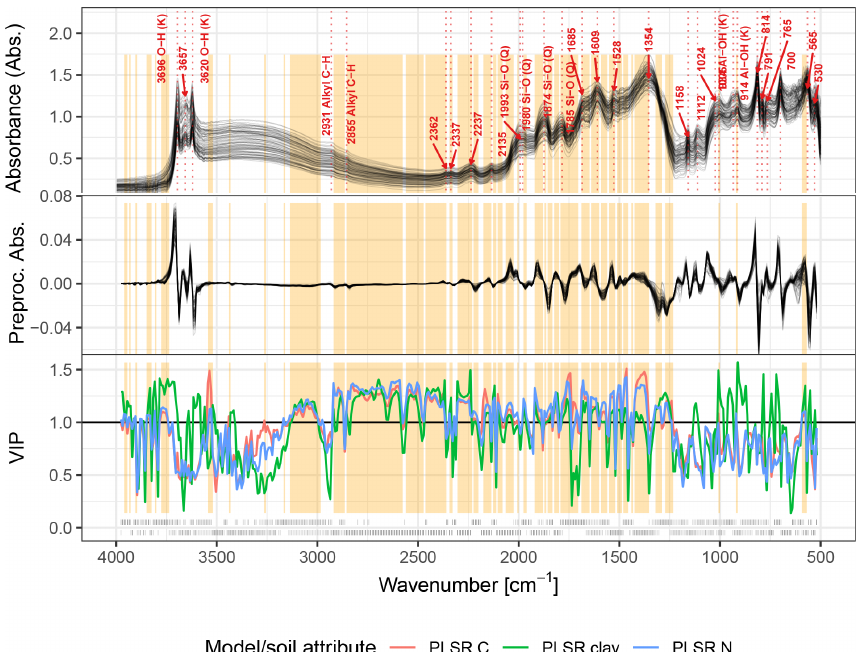
Figure 4. Variable importance analysis of partial least squares regression (PLSR) models for the concentrations of total soil C and total N and clay content, including overlaid raw and preprocessed spectra. The top panel shows resampled mean sample absorbance spectra ( n = 94). Prominent peaks were identified as local maxima with a span of 10 points 20cm − 1 for the selected wavenumbers. Fundamental mid-IR vibrations that are well described in the literature (e.g., Madejová et al., 2002; Rossel and Behrens, 2010; Stevens et al., 2013) were added as labels when identified peaks matched literature assignments. ( Q ) stands for quartz and ( K ) for kaolinite. The middle panel depicts preprocessed spectra (Savitzky–Golay first derivative with a window size of 21 points (42cm − 1 ); third-order polynomial fit). The bottom panel shows variable importance in the projection (VIP) for three selected well-performing PLSR models (total C, total N and clay; R 2 > 0 . 81). The horizontal black line at VIP = 1 indicates the threshold above which absorbance at a given wavenumber contributes more than the average (wavenumber) to the spectral variance explained of a certain soil property. Dashed points closely below the y = 0 line of the VIP graph visualize positive (above y = 0) and negative (below y = 0) PLSR β